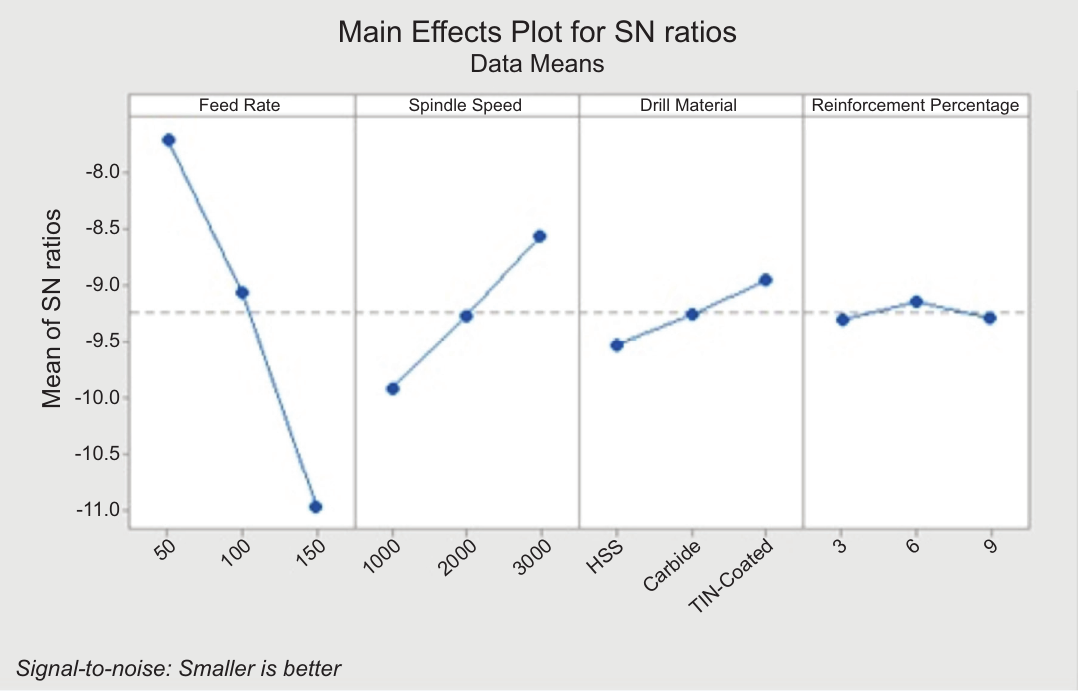
Fig. 8. Response graphs for surface roughness (LM6/B 4 C/FA).